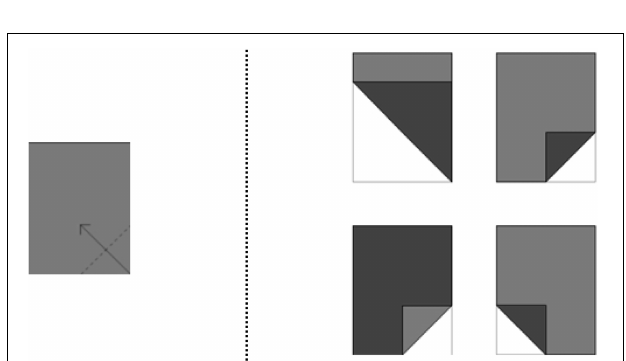
FIGURE 2 | The Mental Folding Test for Children.